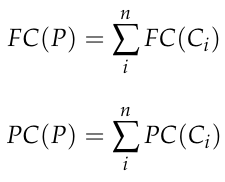
where FC represents the financial cost and PC represents the performance cost. The parent node is denoted by P and the child nodes i ( i = 1, 2, …, n ) are denoted by C i .